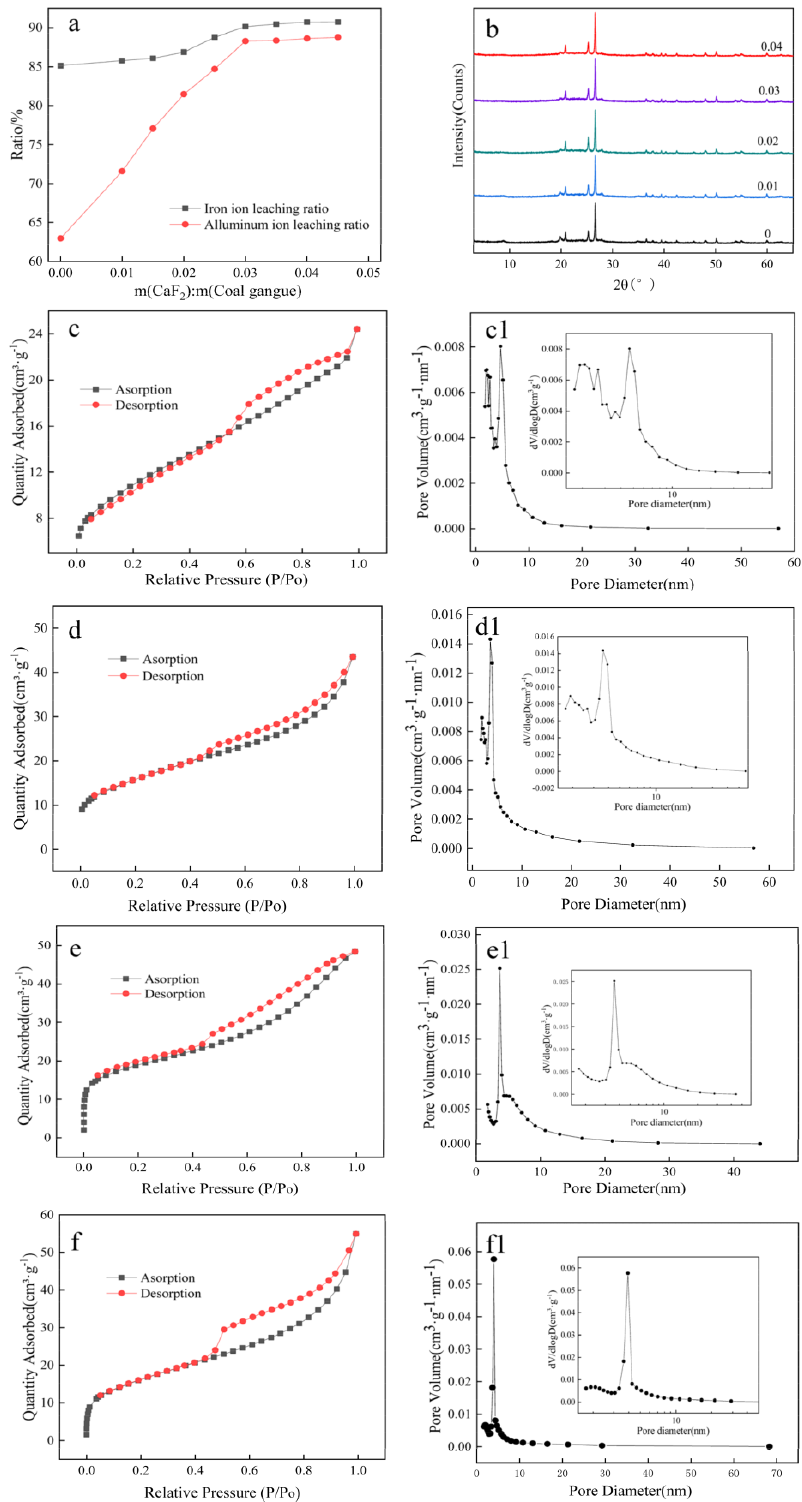
Figure 4. Effect of different additions of CaF 2 on the adsorption quantity and pore volume of the residues. Adsorption: N 2 adsorption curve of the sample; Desorption: N 2 desorption curve of the sample. ( a ) are the relationships between CaF 2 addition and Al-Fe leaching ratios, ( b ) are the XRD spectra of the filter residues after adding different CaF 2 , and ( c , c1 , d , d1 , e , e1 , f , f1 ) are the BET plots of the acid leaching filter residues after adding 0, 0.01 g/g, 0.02 g/g, and 0.03 g/g CaF 2 ,